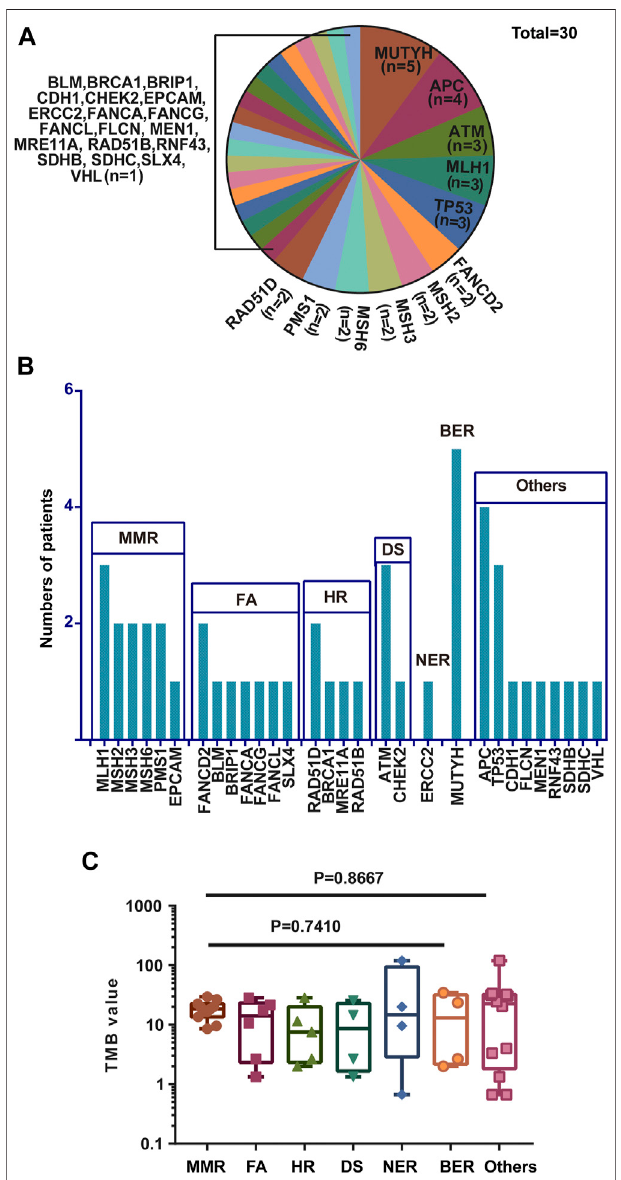
FIGURE1| Gene names, functions, and number ofvariationsofall P/LP germline mutations. (A) Gene names and the ratio of mutations of P/LP germline variations. (B) Speci fi c gene mutation number with each DDR pathway in the P/LP group. (C) Comparison of the TMB with somatic mutations among different pathways in the P/LP group. pathogenic/likely- pathogenic: P/LP; DDR: DNA damage response; TMB, tumor mutation burden; HR, homologous recombination; FA, fanconi anemia; MMR, mismatch repair; NER, nucleotide excision repair; BER, base excision repair; DS, DNA